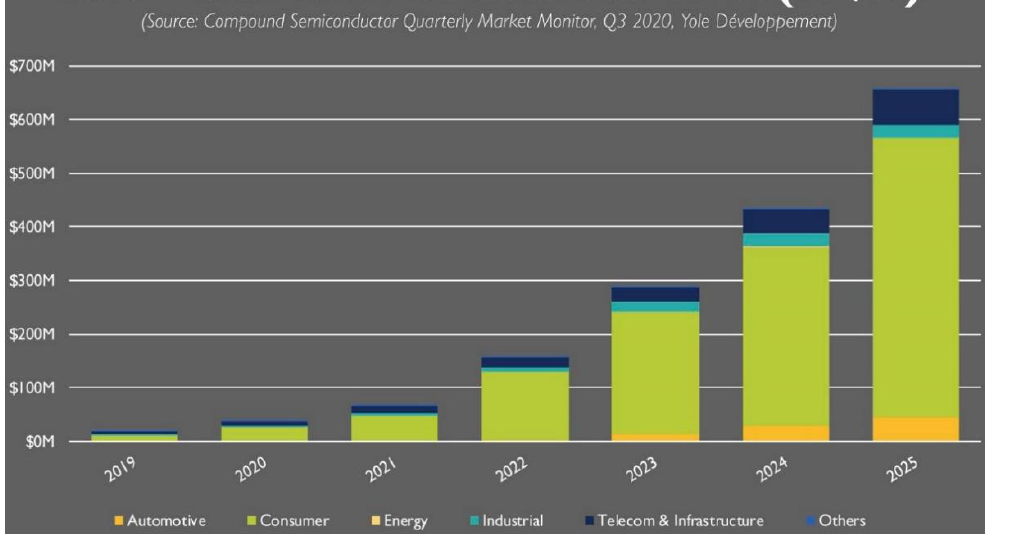
Figure 6. GaN Power device market size prediction by Yole. Reproduced with permission [5]. Copyright 2020, published by Yole Développement.